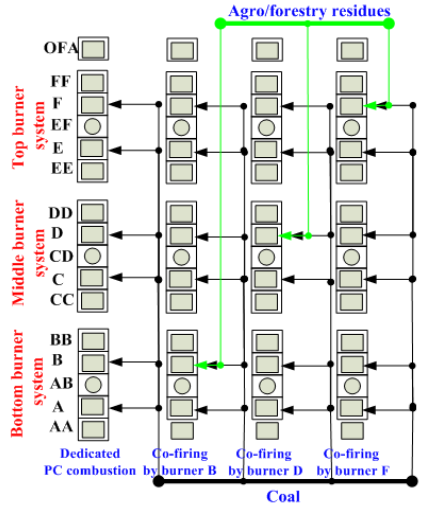
Figure 3. Schematic illustration of co-firing conditions.